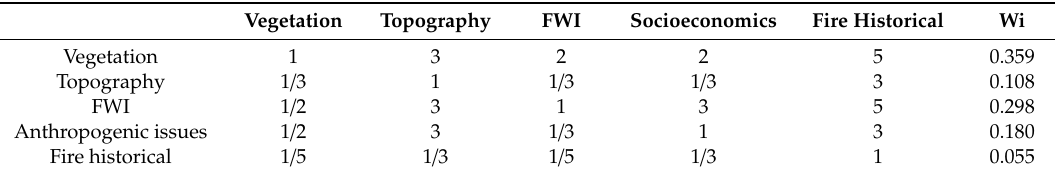
Table 6. Results of weight calculated for each group.